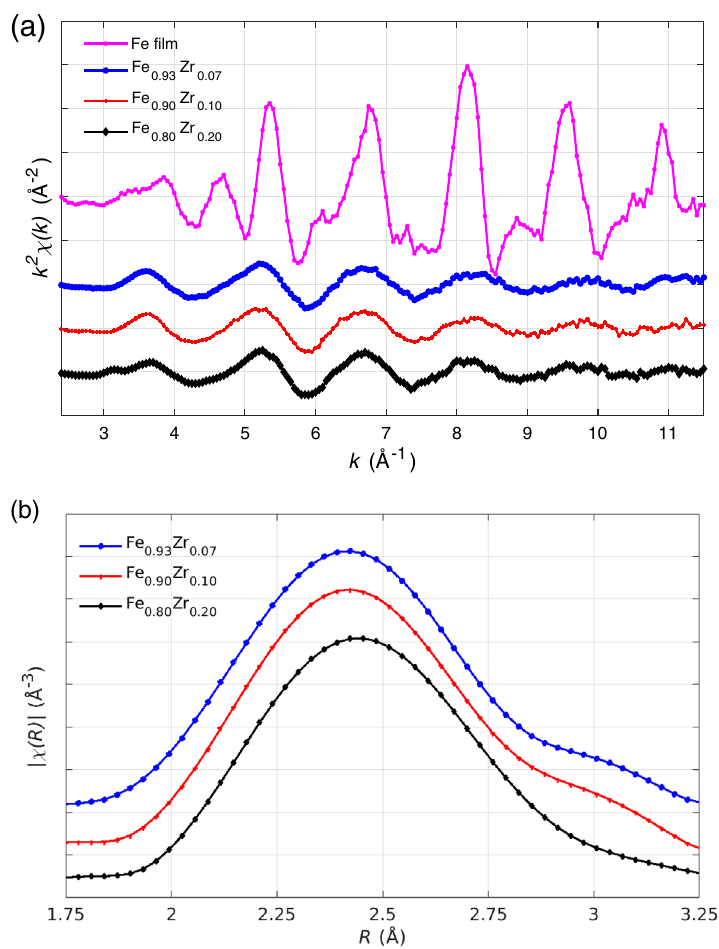
2 χ Figure 5. ( a ) EXAFS signal k measured at 80 K for Fe 0.93 Zr 0.07 , Fe 0.90 Zr 0.10 , Fe 0.80 Zr 0.20 , and the reference crystalline BCC-Fe film. ( b ) Its Fourier transform plotted with phase-correction for the three amorphous samples. All data are shifted vertically for clarity with the zero levels indicated by the grid.